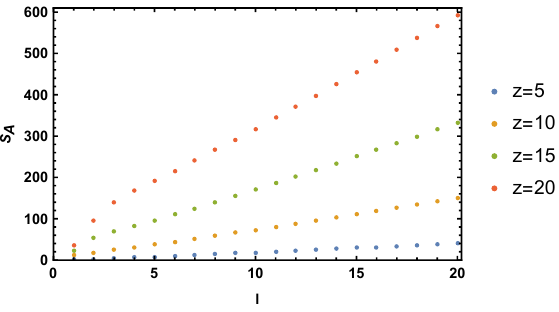
Figure 9 . The area law behavior of entanglement entropy for di(cid:11)erent values of z for square entangling region. We have set N x = N y = 250 and m = 0 with Dirichlet boundary condition. similar to Lorentzian theories, in Lifshitz (cid:12)eld theories the singularities of the entangling regions bring in a logarithmic divergent term in